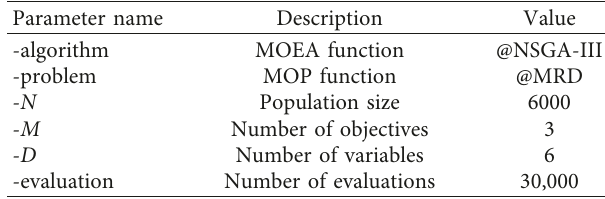
Table 3: Acceptable parameters for PlatEMO. Table 2: Parameters of geometric